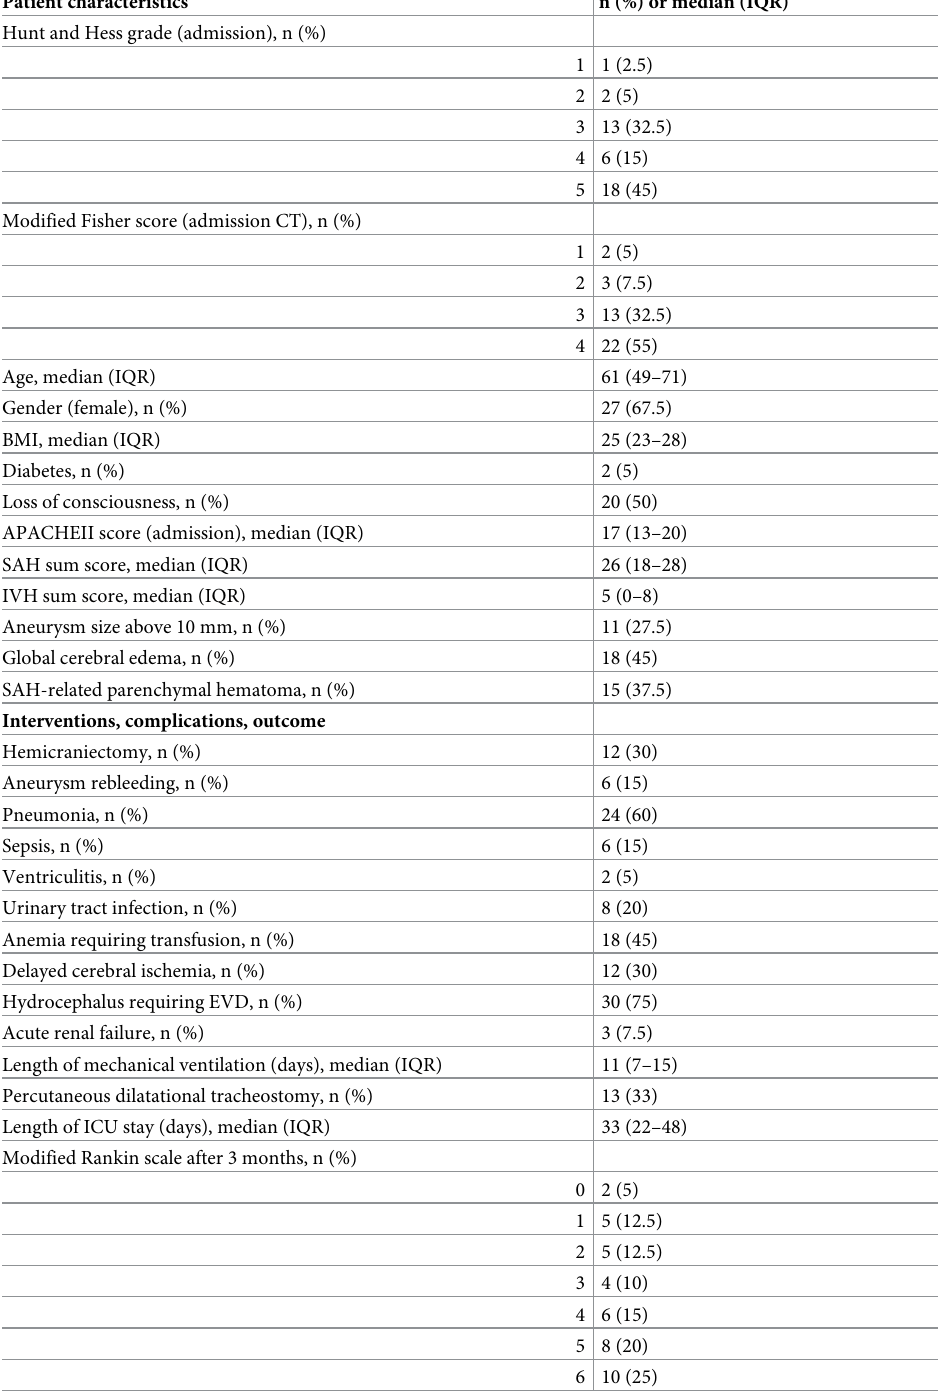
Table 1. Patient characteristics, interventions, complications and